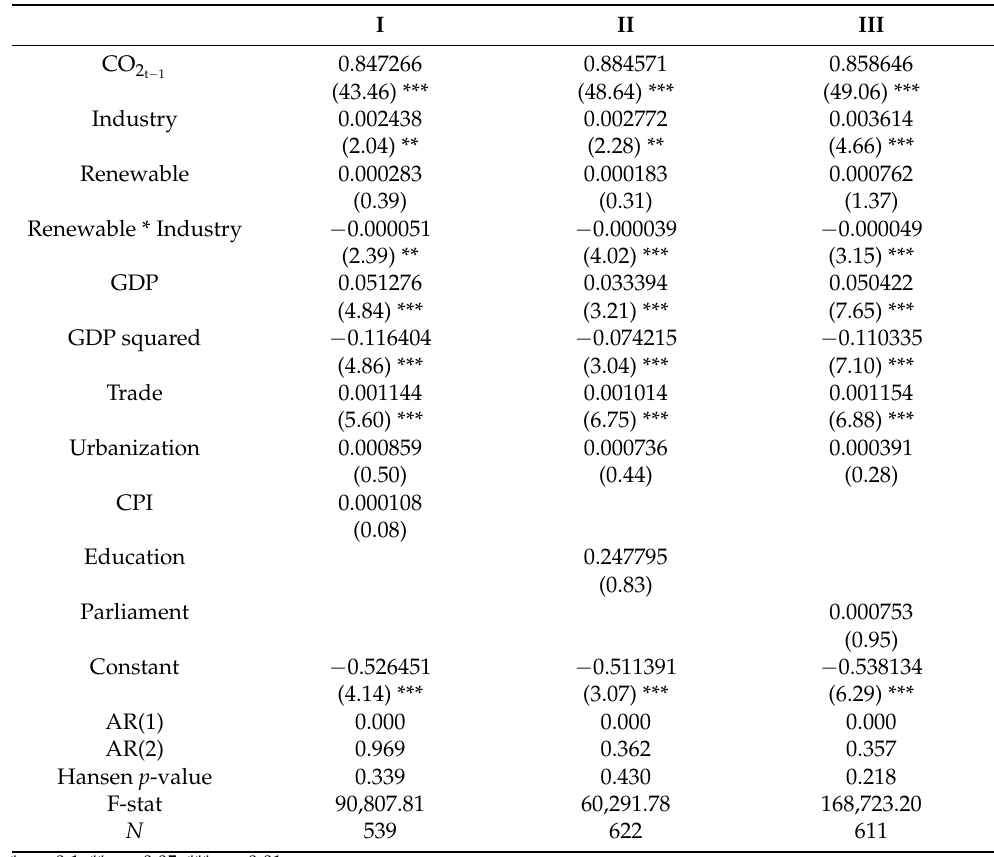
Table 4. Additional